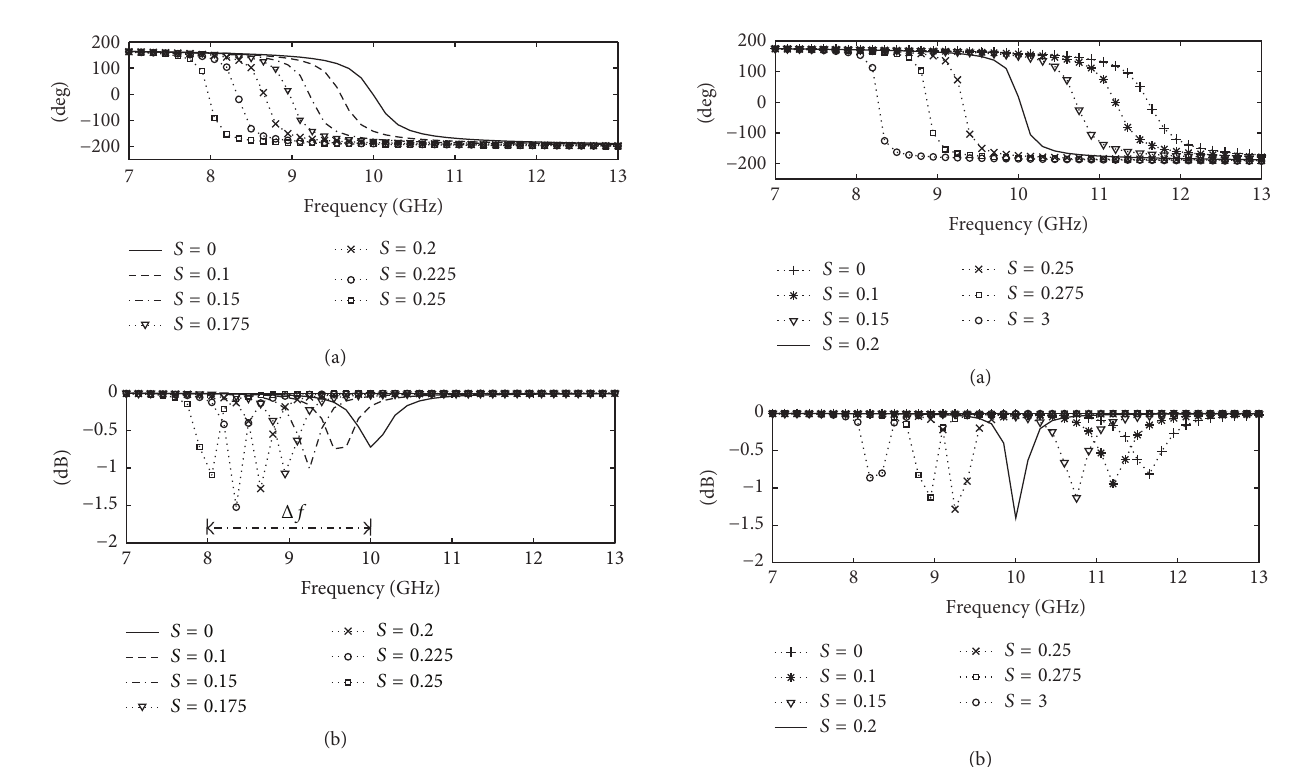
Figure 7: (a) Phase and (b) amplitude of the simulated reflection coefficient versus frequency for different value of the scaling factor 𝑆 (1st iteration fractal unit cell with 𝐿 = 9.215 mm and Δ𝑥 × Δ𝑦 = × 0.6𝜆 0.6𝜆 0 0 ).